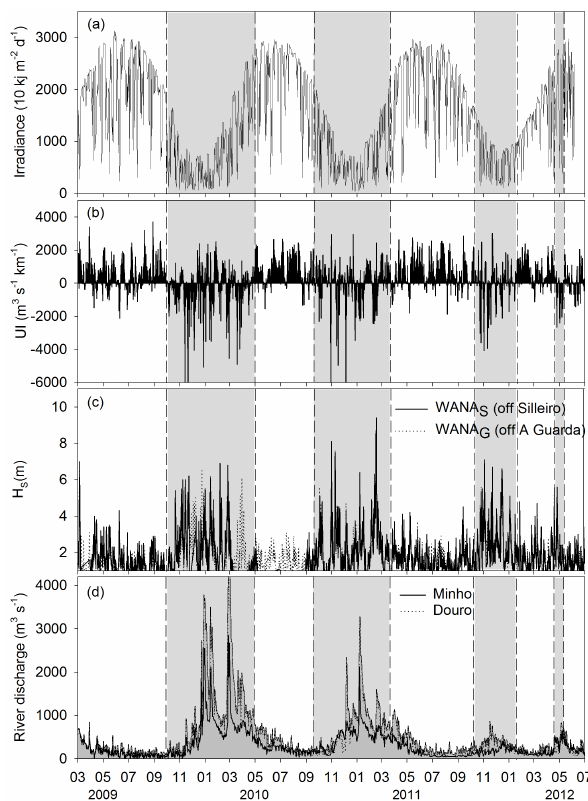
Figure 2. Temporal series of (a) total irradiance at Cíes Islands sta- tion (IR), (b) upwelling index (UI), (c) significant wave heights ( H s ) obtained from the points off Silleiro and off A Guarda WANA and (d) Minho and Douro river discharge. Upwelling and downwelling periods are highlighted with white and grey bars, respectively, based on upwelling index and biogeochemical data presented in Zúñiga et al.